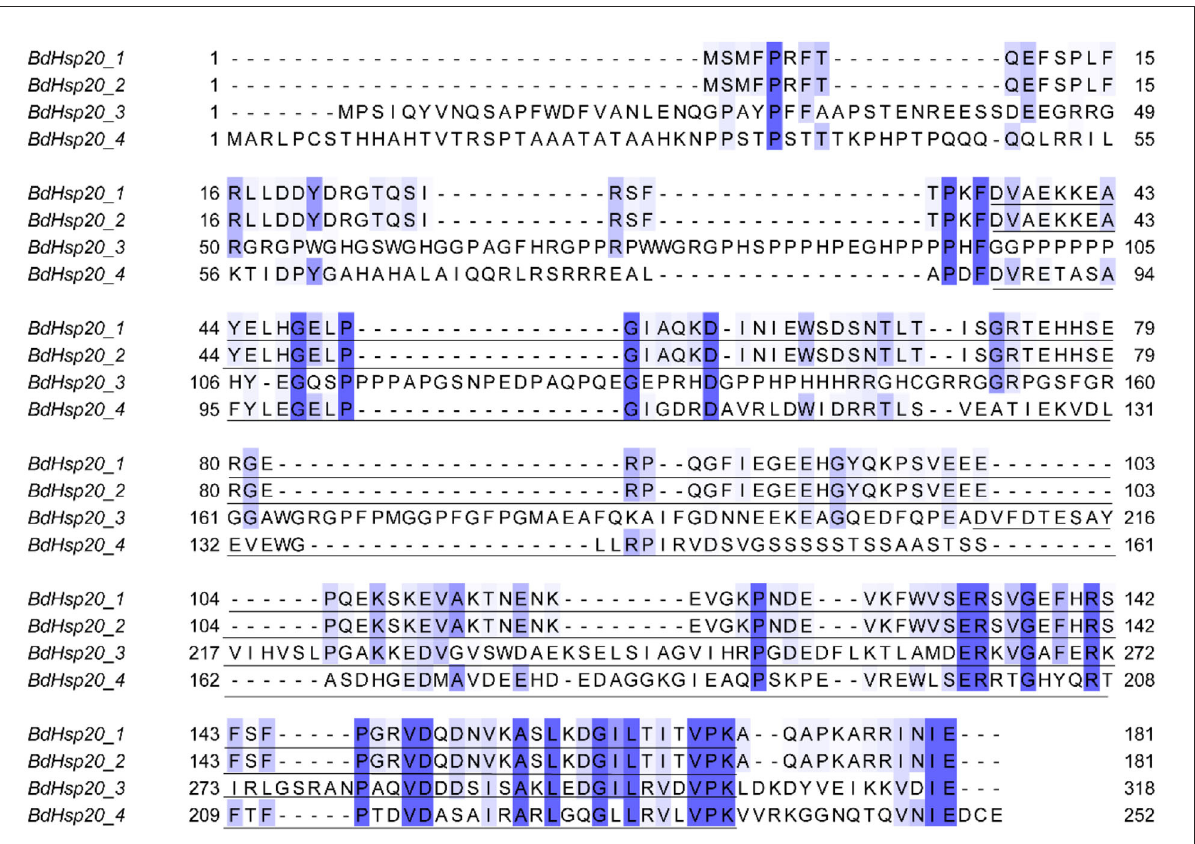
FIGURE1 Alignment of the BdHsp20 gene family. The underlined sequences in BdHsp20_1 (36 aa − 169 aa), BdHsp20_2 (36 aa − 169 aa), BdHsp20_3 (208 aa − 304 aa), and BdHsp20_4 (87 aa − 235 aa), were the conserved alpha-crystallin domain. Each sequence also has a variable N-terminal region and a short C-terminal